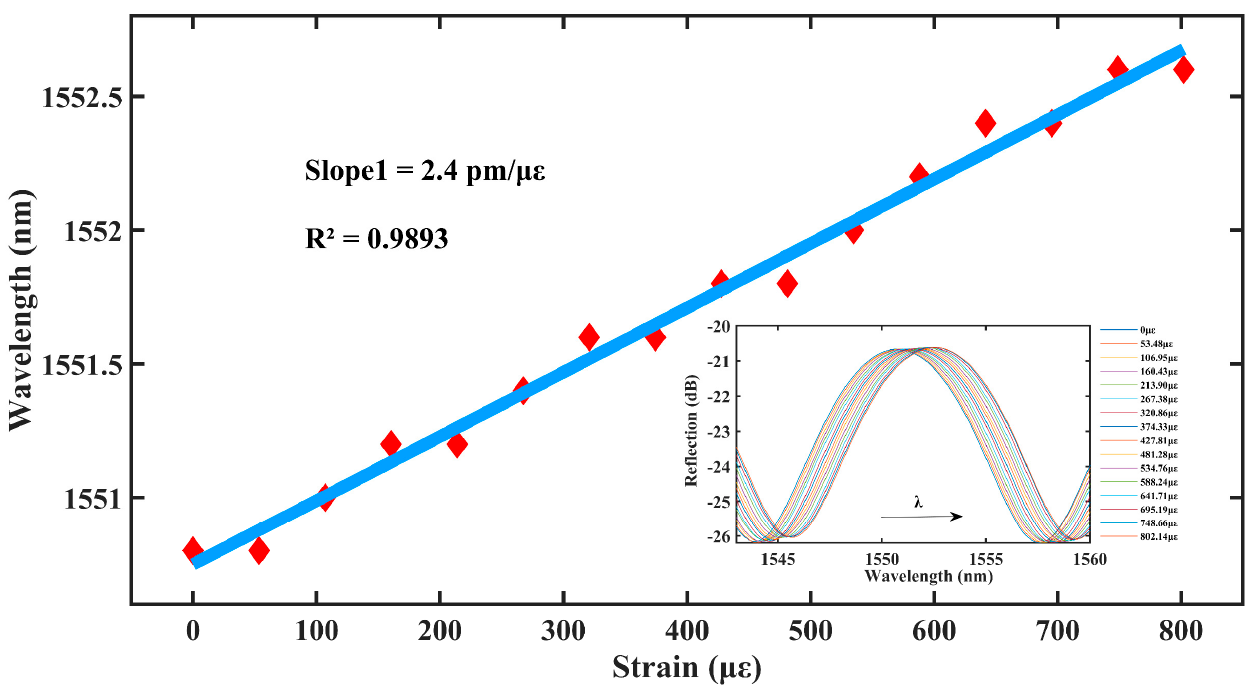
Figure 5. Single bubble of strain drift and fit plots.